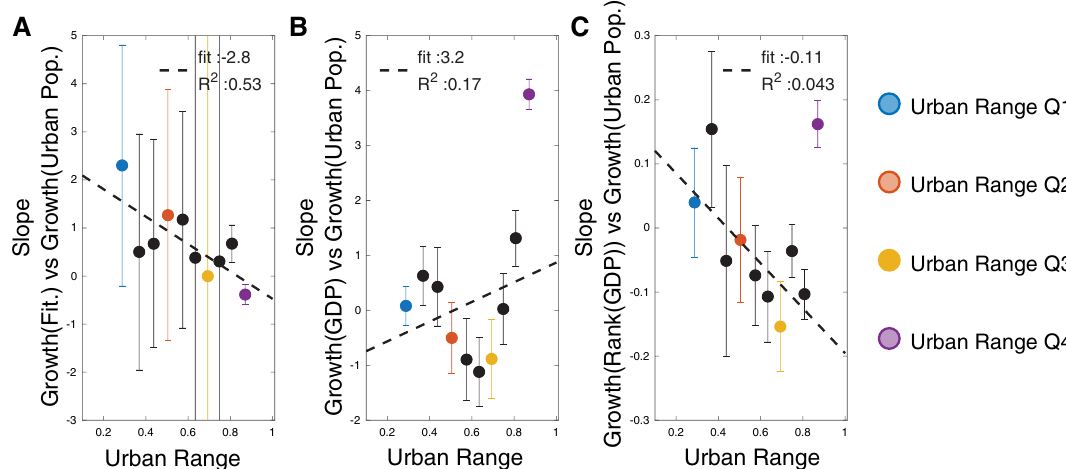
Figure 5. Slope coefficient of a sliding window across 25% of the countries (corresponding to 36 countries) of respectively its Fitness Growth Rate ( A )— GDP Growth Rate ( B )— GDP Ranking Growth Rate ( C ) versus Urban Population Growth Rate. The error bar corresponds to the fit’s 95% confidence interval. The colors follow the Urban Range